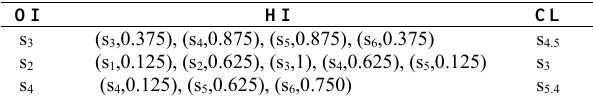
Table 2. Unified results of linguistic values in the set with 5 labels represented by triangular fuzzy number.